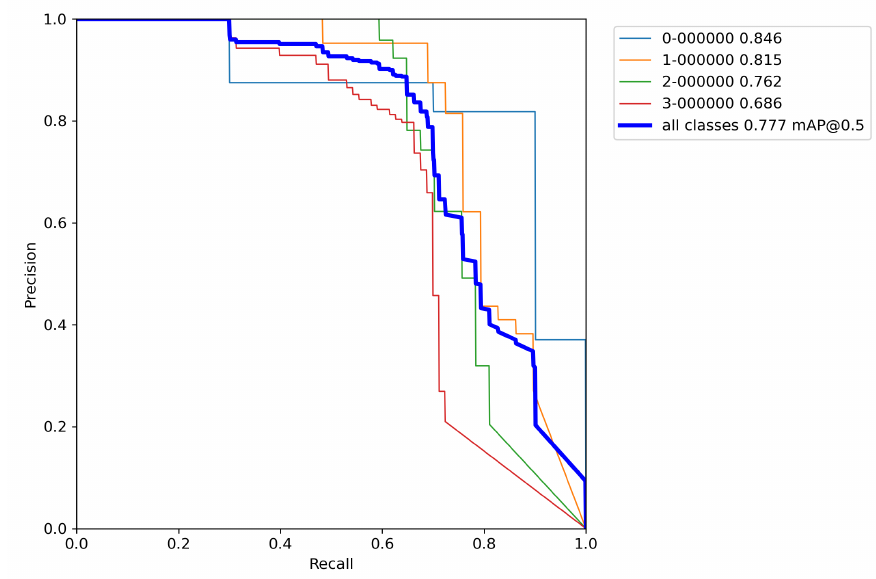
Figure A15. Model trained with augmentation pipeline P–R curve—Experiment